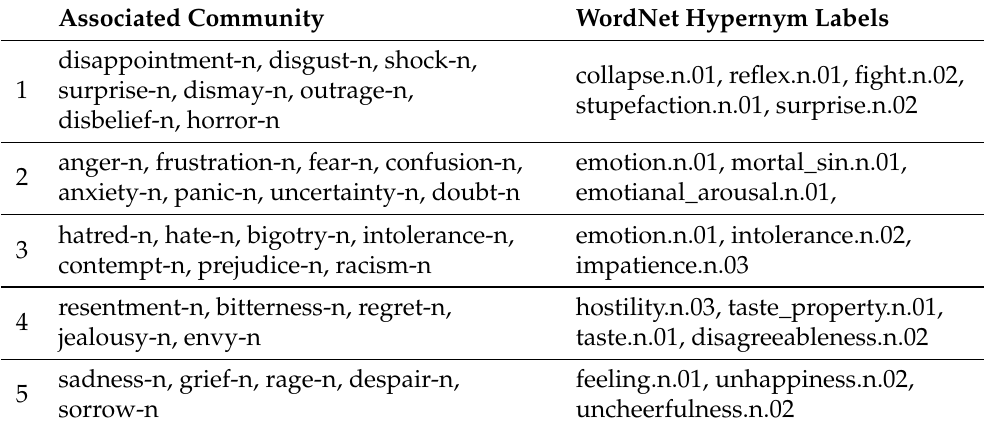
Table 7. Best-ranked WordNet hypernym labels for associated communities FoF [ and | or ] anger the source lexeme anger-n in English Timestamped newsfeed 2014–2019 corpus extracted through the F [ hyper ] hypernym graph. anger